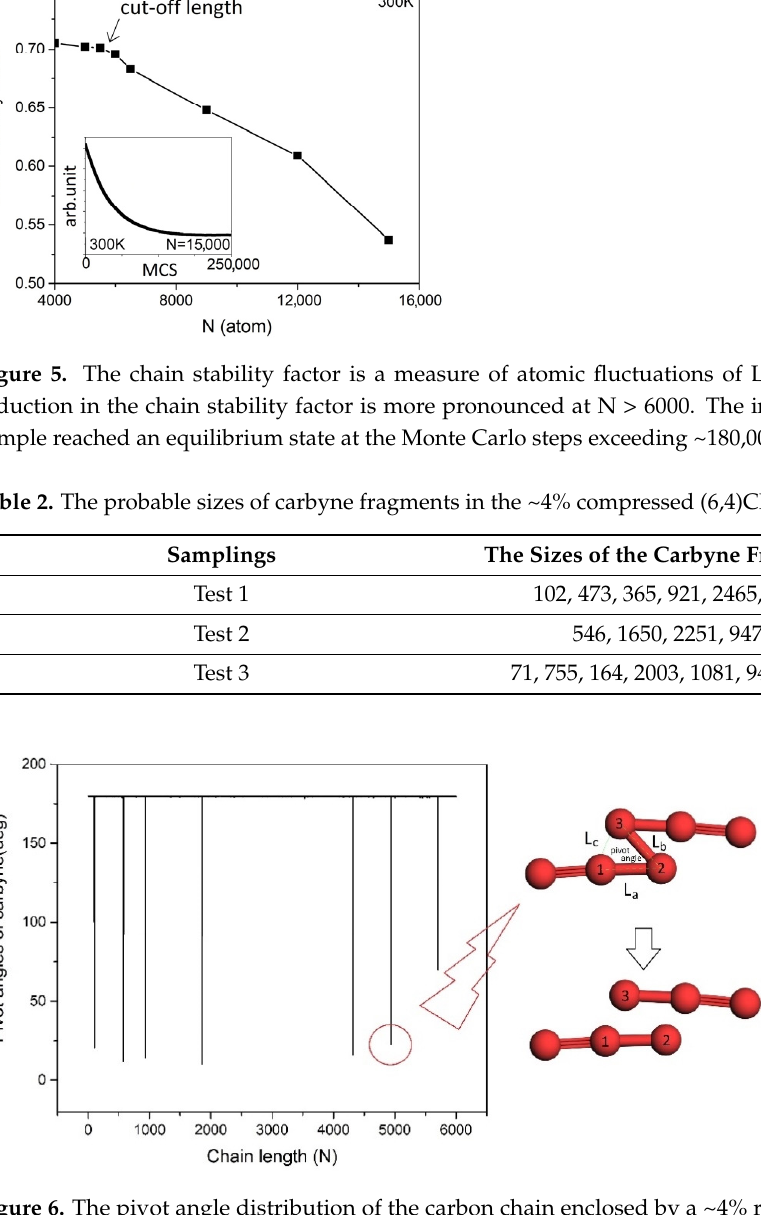
Figure 6. The pivot angle distribution of the carbon chain enclosed by a ~4% radially compressed CNT. Seven critical kink structures with shape pivot angles are observed. One of the critical kink structures is drawn schematically (not to scale). L c , L b , and L a form a pivot angle. L b ~1.73 Å and 1.5 Å < L a < 1.6 Å are always observed in all the critical kink structures. Formation of 7 + 1 = 8 carbyne fragments is expected at an instantaneous moment of chain breakage in test 1 (Table 2). The electrostatic repulsion between the sites ‘1’ and ‘3’ is stronger than triple-bond strength. Table 2. The probable sizes of carbyne fragments in the ~4% compressed (6,4)CNT at 300 K. Samplings